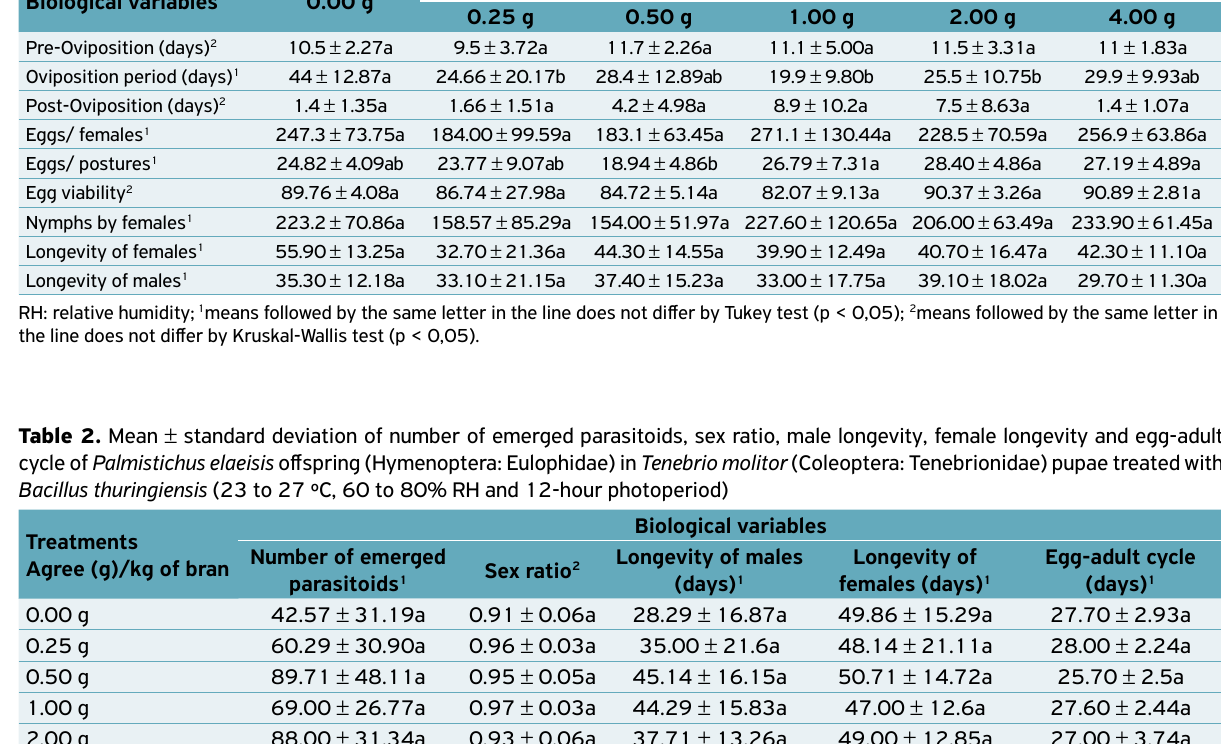
Table 1. Biological variables (mean ± standard deviation) of Podisus nigrispinus (Hemiptera: Pentatomidae) fed on Tenebrio molitor (Coleoptera: Tenebrionidae) larvae treated with Bacillus thuringiensis (23 to 27 ºC, 60 to 80% RH and 12-hour photoperiod) Biological variables